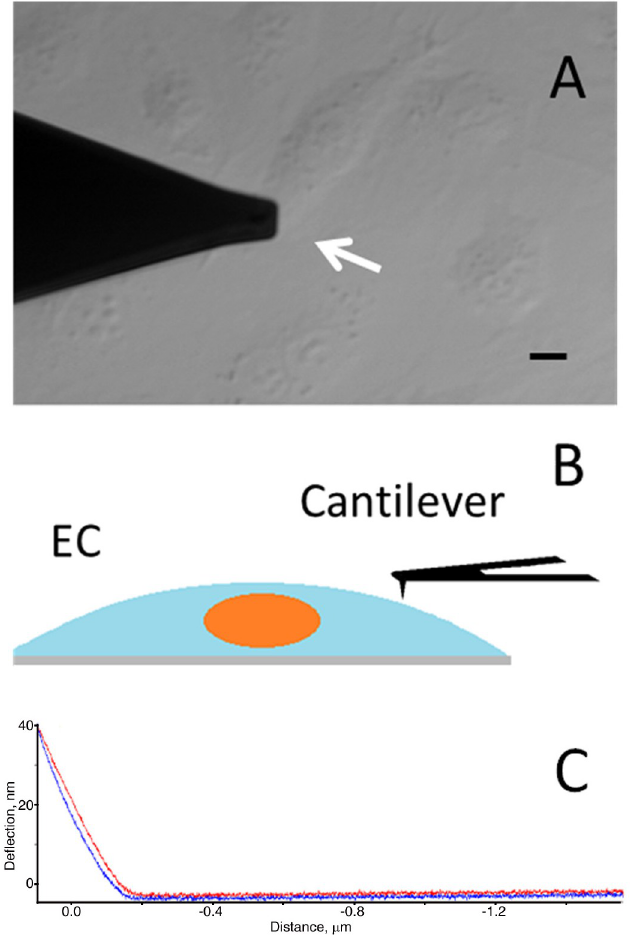
Fig 2. Representative pictures (A, C) and diagram (B) of the approach for quantitating cell stiffness. EC stiffness was measured by indenting a HBME cell on the cell cortex (arrow in A) with the tip at the end of the cantilever (A and B). The corresponding force curve included approach (red in C) and retraction (blue in C) curves that show cantilever deflection. Cell stiffness (Young’s modulus) was converted from the approach curve. Scale bar in A = 10 μ